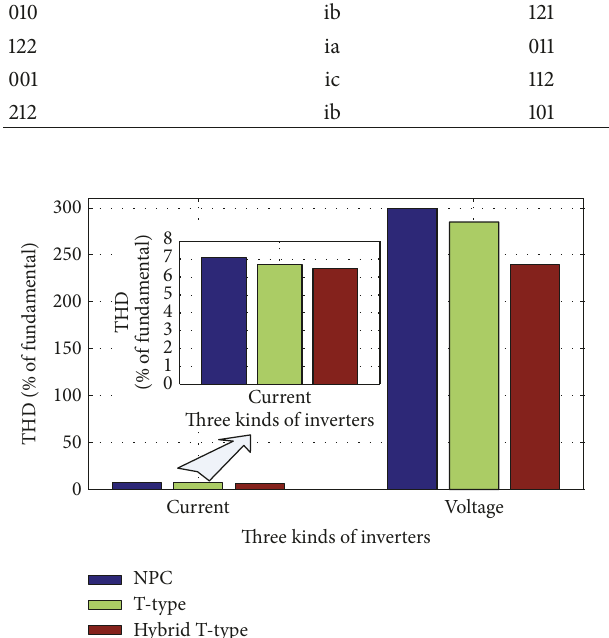
Figure 13: The current and voltage THD comparison of three types of